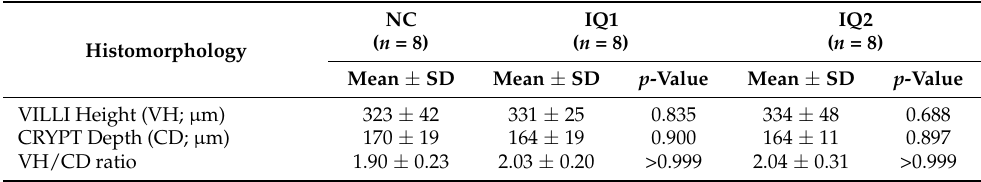
Table 8. Histomorphological measurements in ileal tissue of piglets 5 days after weaning at day 21, born from sows that received either a basal diet (NC), or supplementation with isoquinoline alkaloids (IQ) during gestation and lactation (IQ1), or only during the lactation period